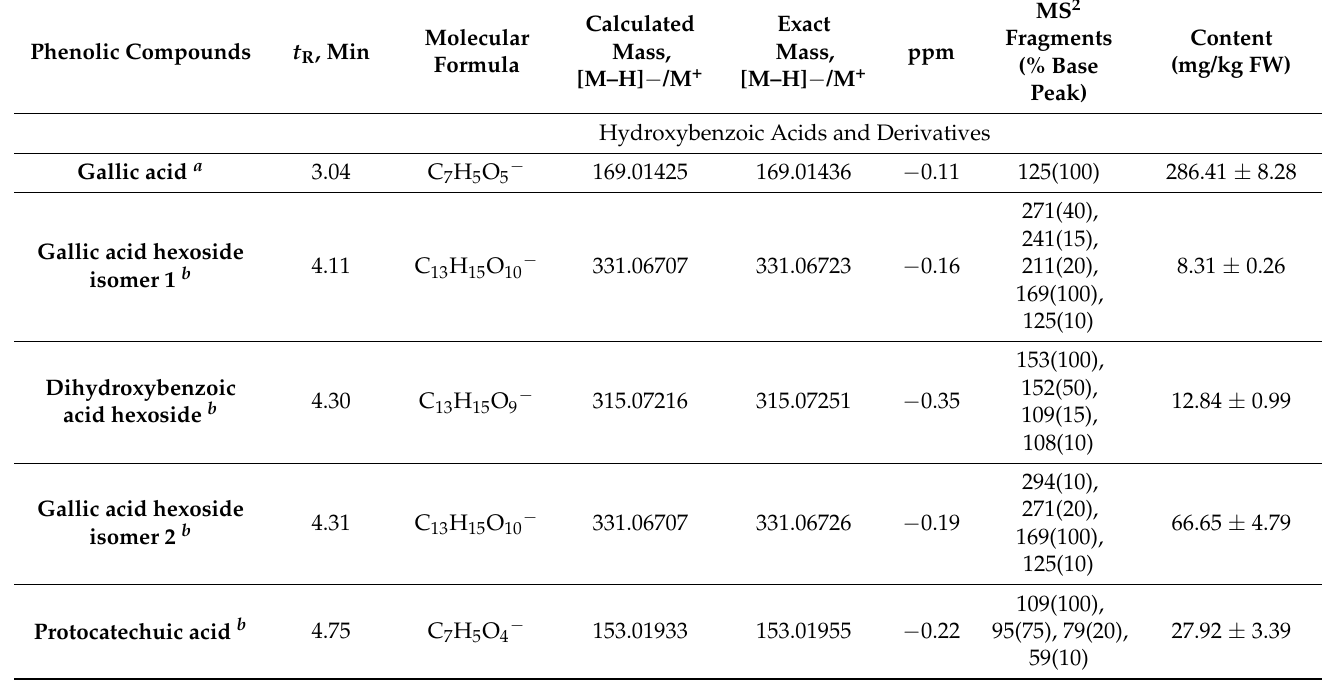
Table 1. The content of phenolic compounds (results are expressed as mg/kg FM) in aqueous grape pomace seed extract of Prokupac variety, determined using UHPLC-Orbitrap MS; retention time ( t R ), molecular formula, calculated/exact mass, mean mass accuracy (ppm), and major MS 2